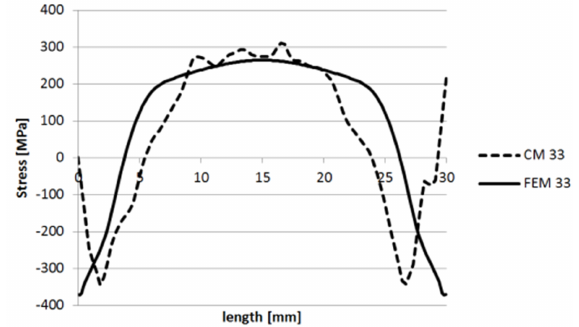
Figure 37. Stress levels in 33 direction along the CD line segment.